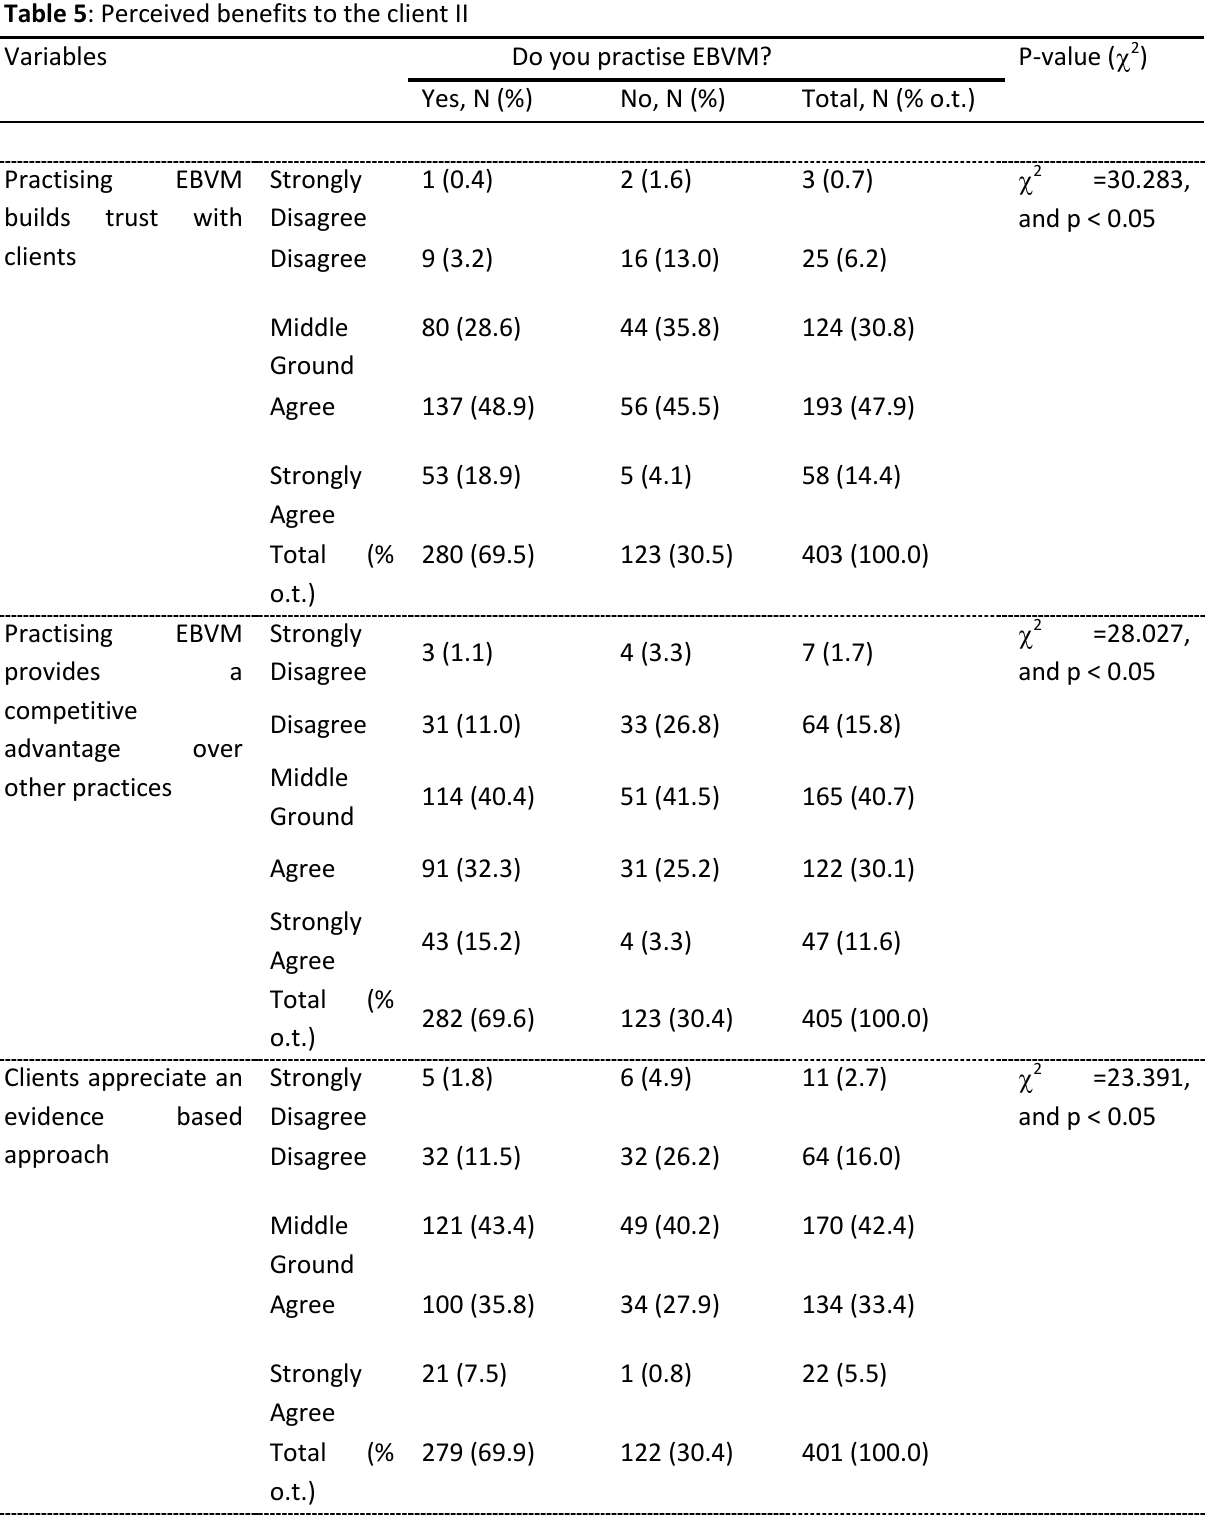
Table 5 : Perceived benefits to the client II Variables Do you practise EBVM? P-value (  2 ) Yes, N (%) No, N (%) Total, N (%